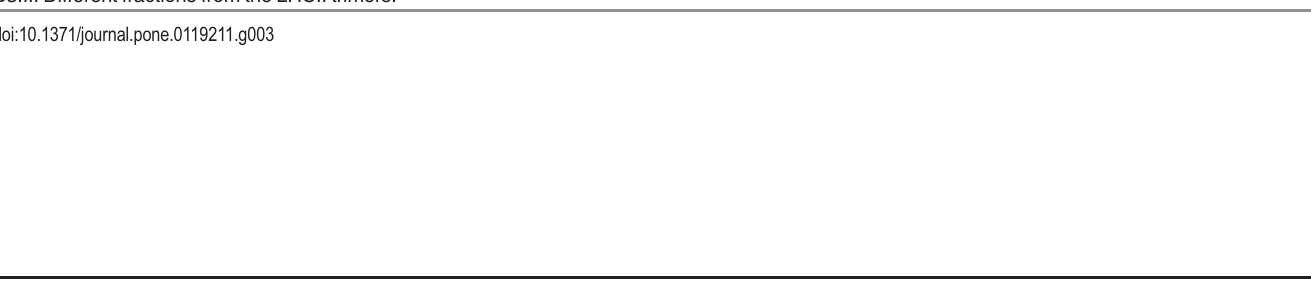
PLOS ONE | DOI:10.1371/journal.pone.0119211 February 27,